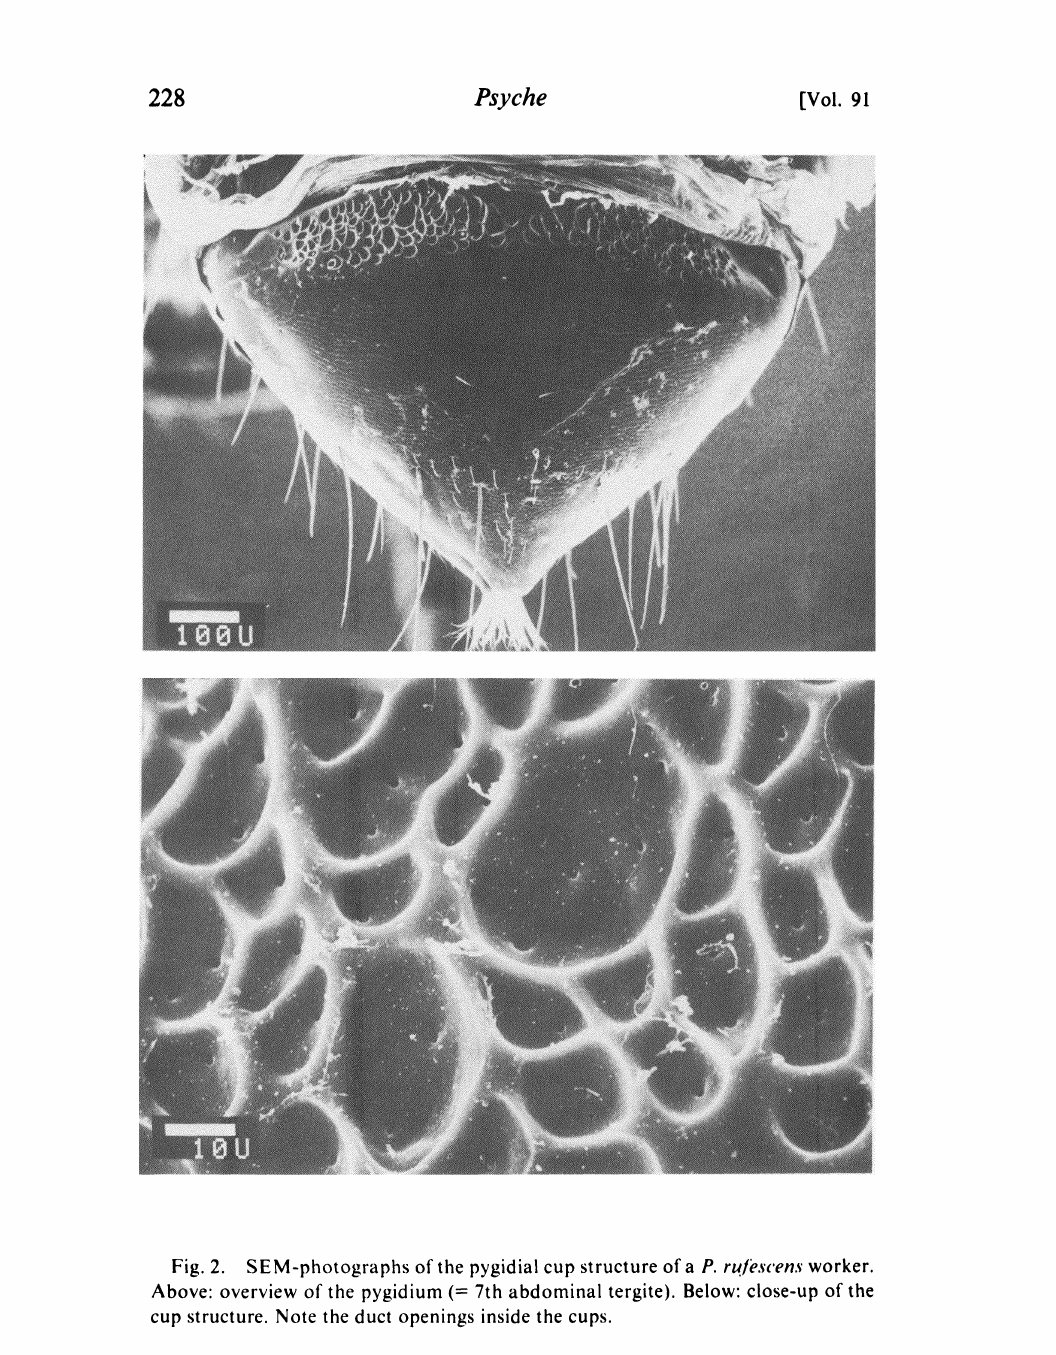
Fig. 2. SEM-photographs of the pygidial cup structure of a P. rufescens worker. Above" overview of the pygidium (= 7th abdominal tergite). Below: close-up of the cup structure. Note the duct openings inside the